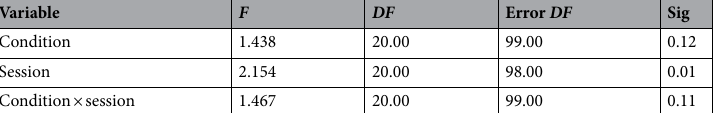
Table 3. MANOVA results in FM patients. Dependent variable: 20 fNIRS channels for oxyhemoglobin level, factors: Condition (Resting State vs Grasping Flat vs Grasping Sharp-tip object) and Session (Time-to-contact detection vs Observation-only).